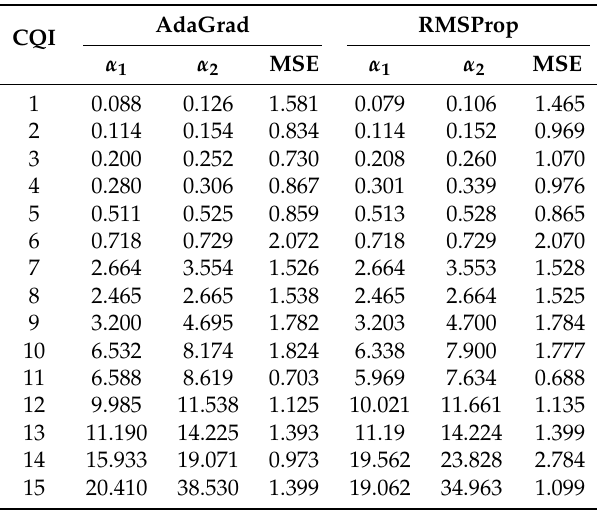
) in 5G TDL-A 2 × 2 , α ∗ 2 1